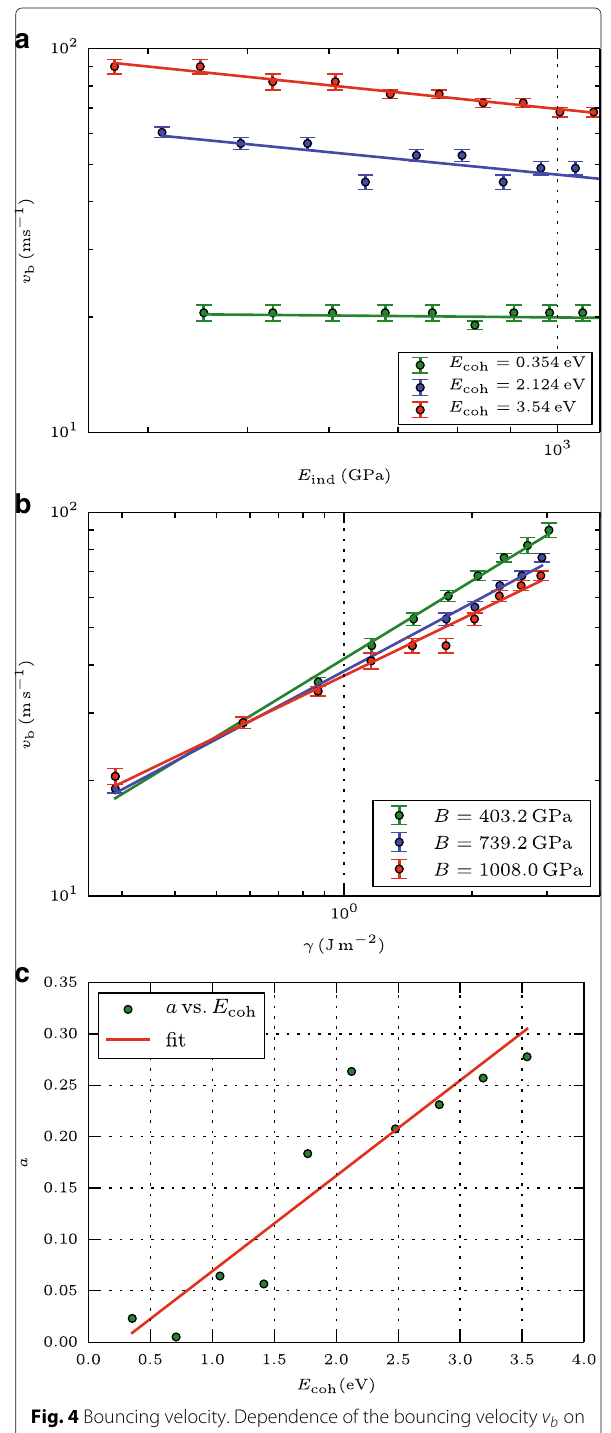
Fig. 4 Bouncing velocity. Dependence of the bouncing velocity v b on the a indentation modulus E ind and the b surface energy γ . Lines denote power-law fits. c displays the dependence of the power exponent, a , Eq. (4), on the cohesive energy. The line denotes a linear fit to guide the